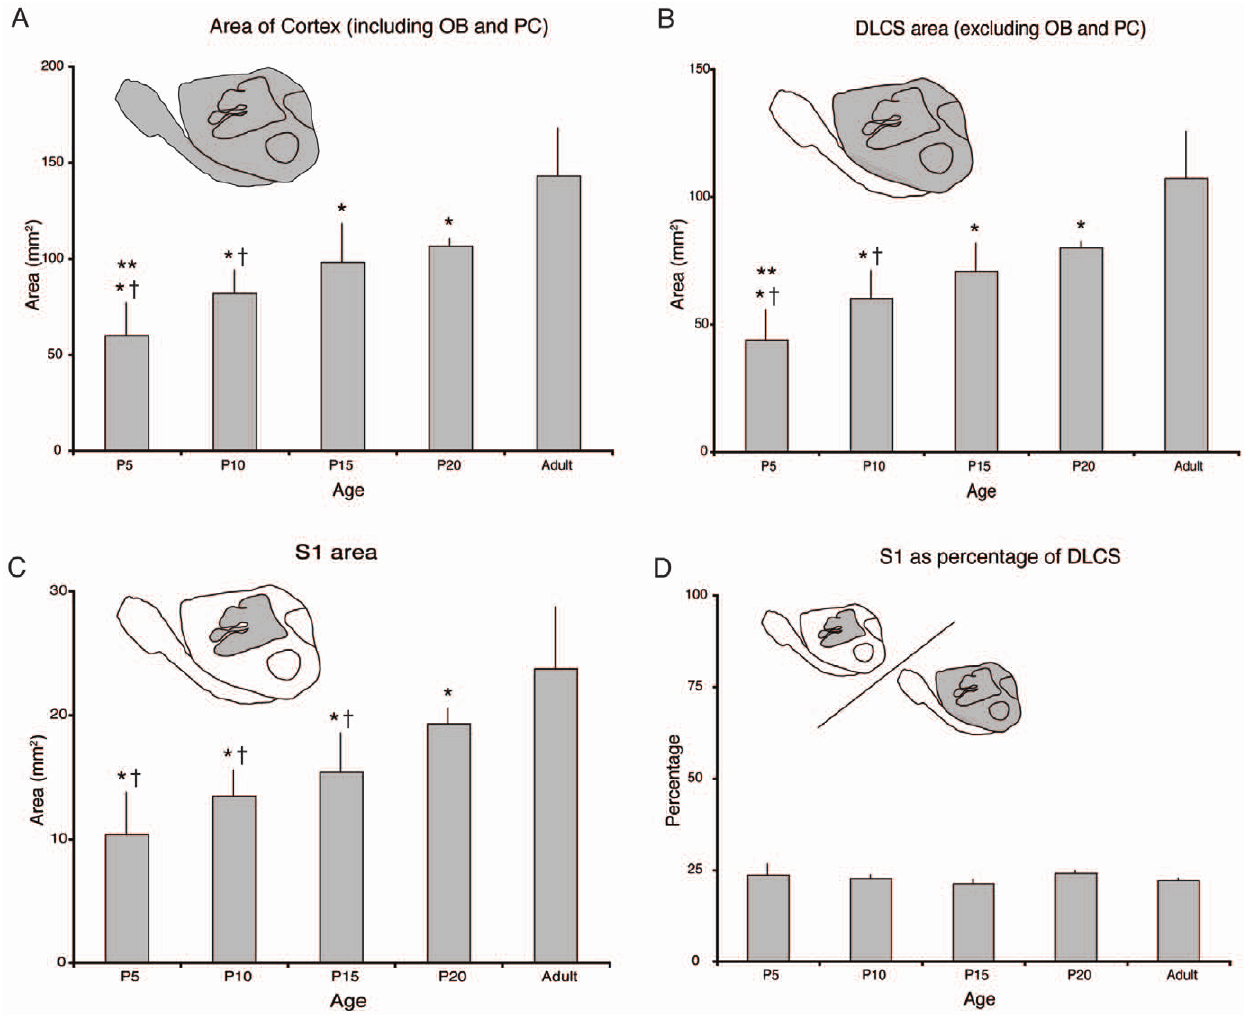
Figure 7. Measurements of different cortical areas. The shaded portion of the brain schematic represents the area being measured. A) The mean area (in mm 2 ) of the cortex (including the dorsolateral cortical sheet, pyriform cortex, and olfactory bulb), B) dorsolateral cortical sheet (DLCS), (C) S1, and (D) the percentage of cortex occupied by S1. Note that the size of the complete cortical sheet, DLCS and S1 increases with age. However, the relative size of S1 as measured using architectonic boundaries is unchanged throughout development and adulthood. * - significantly different from adult. { - significantly different from P20. ** - significantly different from P15. Mean + s.d. doi:10.1371/journal.pone.0032322.g007 (Fig. 12B, rf 5 and 8) or both dorsal and ventral surfaces (rfs 4, 6 and 10).